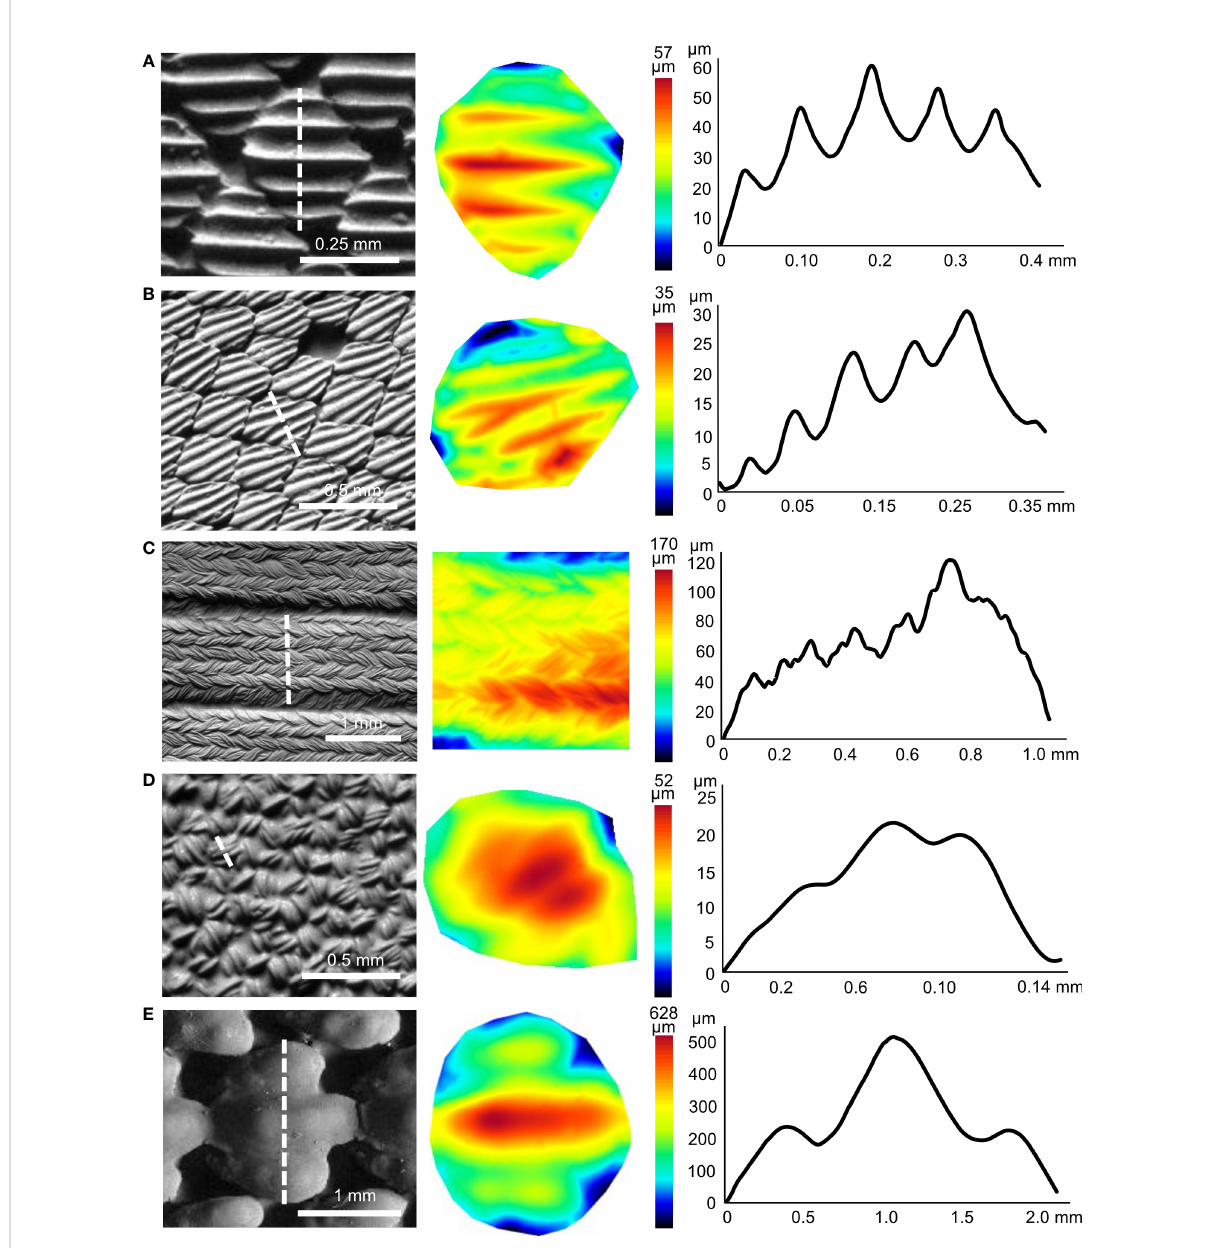
FIGURE 2 Three-dimensional surface structure for different shark skin and material samples. (A) Atlantic sharpnose shark (midbody), (B) Atlantic sharpnose shark (midtail), (C) Speedo ® FS Fastskin II swimsuit, (D) Speedo Lzr ® Racer Elite 2 swimsuit and (E) shark-inspired engineered surface (Domel et al., 2018b). Greyscale images from surface pro fi lometry in the left column, with the white dotted line indicating the extracted pro fi le. The center column shows topographic images (anterior to left) corresponding to the individual denticle or denticle-like structure from the left column, with color indicating surface height. The right column shows height pro fi les from the dotted lines in the left column images. Note that the y- and x-axes in the right column pro fi les are different for each